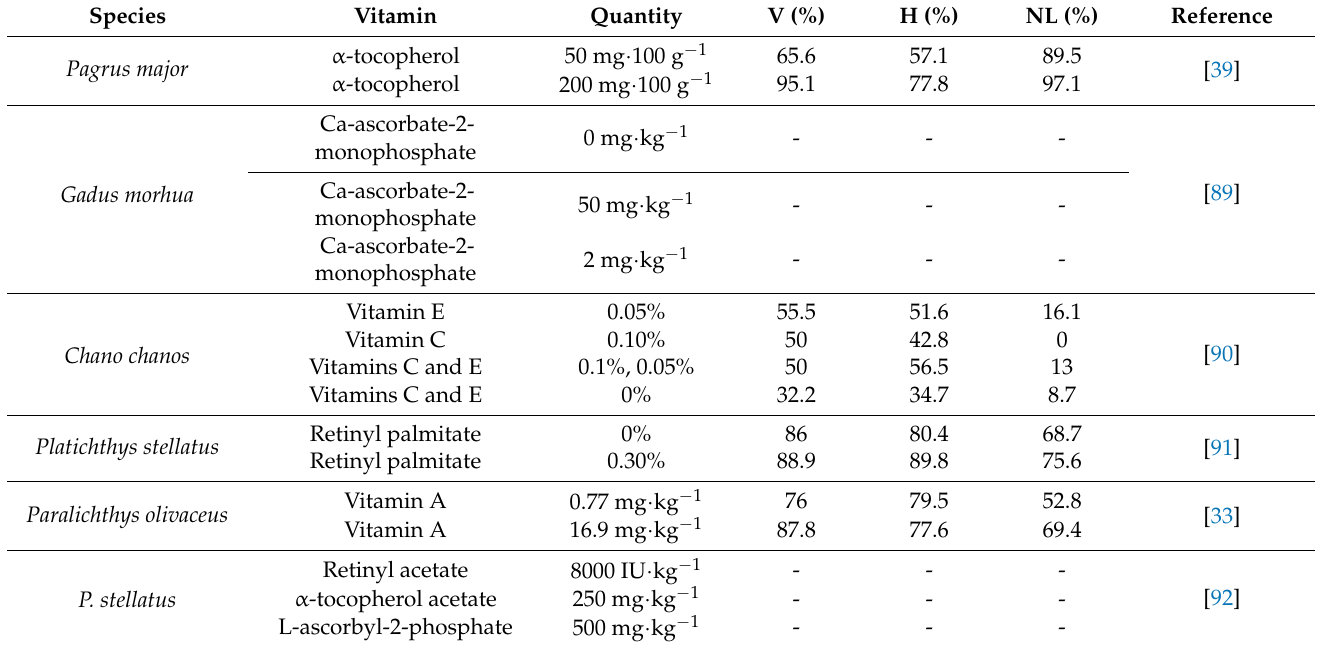
Table 9. Reproductive performance in different fish using different sources of vitamins in diets. V: Viability; H: Hatching; NL: Normal